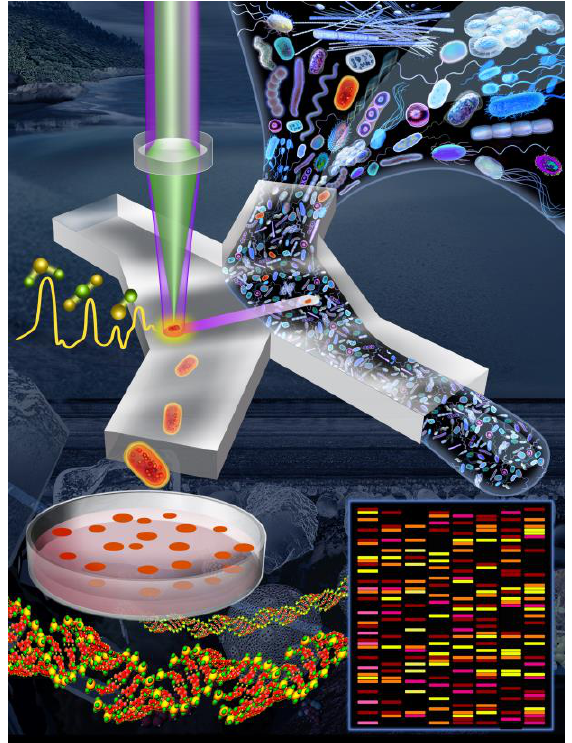
FIGURE 1: Pipeline to link functions of microbial cells to their genes. An environmental sample (e.g., marine, freshwater, soil, mammalian gut) is incubated for a short period in D 2 O-containing minimal medium (i.e., lacking nutrients) supplemented by a spe- cific compound of interest (this initial step is not shown in this image). Cells able to metabolize that compound are active and so become labelled by deuterium (D), shown here in red. The sam- ple is introduced into a microfluidic device in which single cells are captured in optical tweezers and analyzed using a Raman microspectroscope. The status of deuterium-labelled cells is apparent from a characteristic peak in their Raman spectrum. Deuterium-labelled cells (i.e., those with the metabolic property of interest) pass into a collection outlet and are available for subsequent genetic analysis (e.g., metagenomics, single-cell genomics) or cultivation for further phenotypic characterization. Image credit: Lee KS, Gorick G, and Stocker